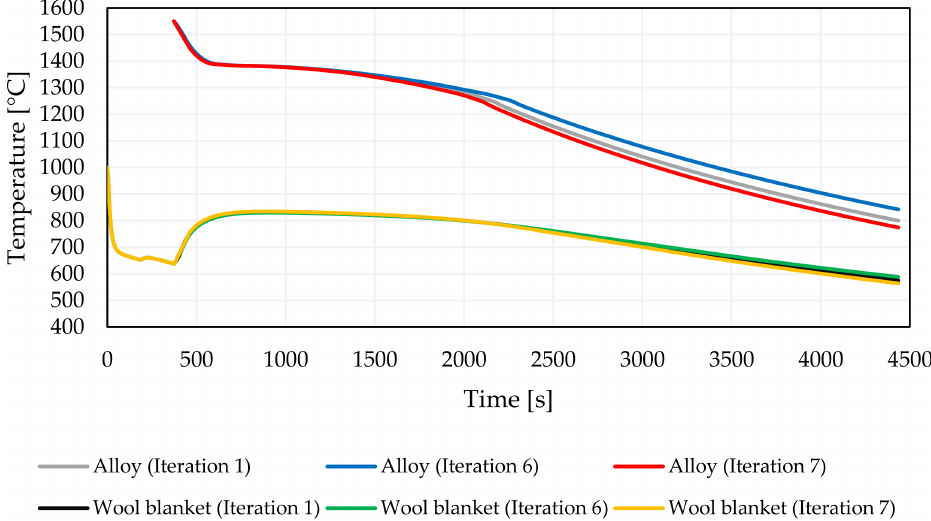
Figure 15. Evaluation of the influence of heat transfer coefficient on the alloy and wool blanket temperature results.